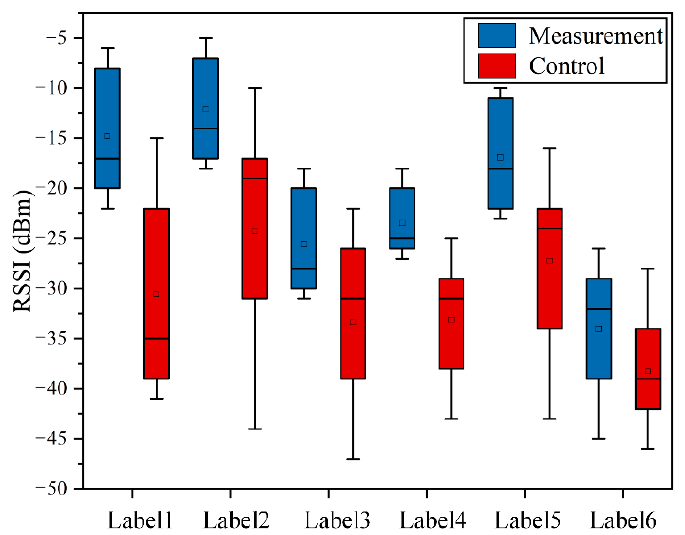
Figure 2. UHF RFID tags selected in the experiment (labeled 1–3 from left to right on the top line, and 4–6 from left to right at the bottom).